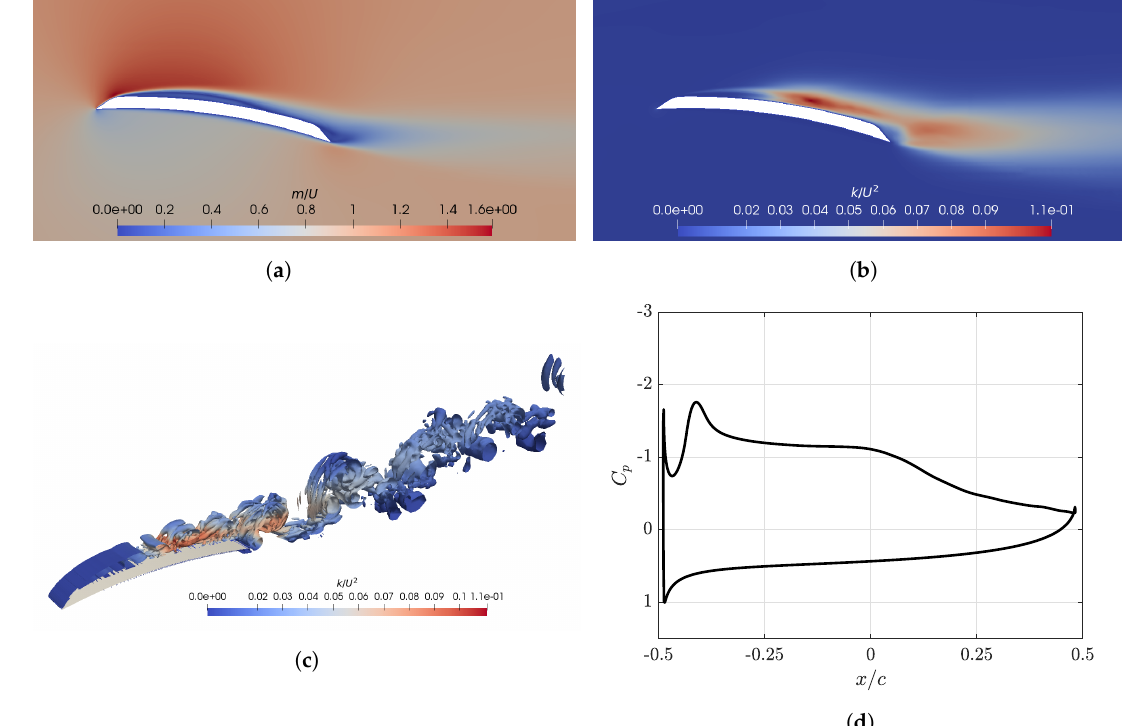
Figure 8. Flow behavior for Re = 10 4 and AoA = 8 ◦ . ( a ) Non-dimensional magnitude of mean velocity m / U ; ( b ) Non-dimensional resolved turbulence kinetic energy k / U 2 ; ( c ) Isosurface of the non-dimensional resolved second invariant of velocity gradient ˜ Q · c 2 / U 2 = 1 colored by the non-dimensional resolved turbulence kinetic energy k / U 2 ; ( d ) Pressure coefficient C p